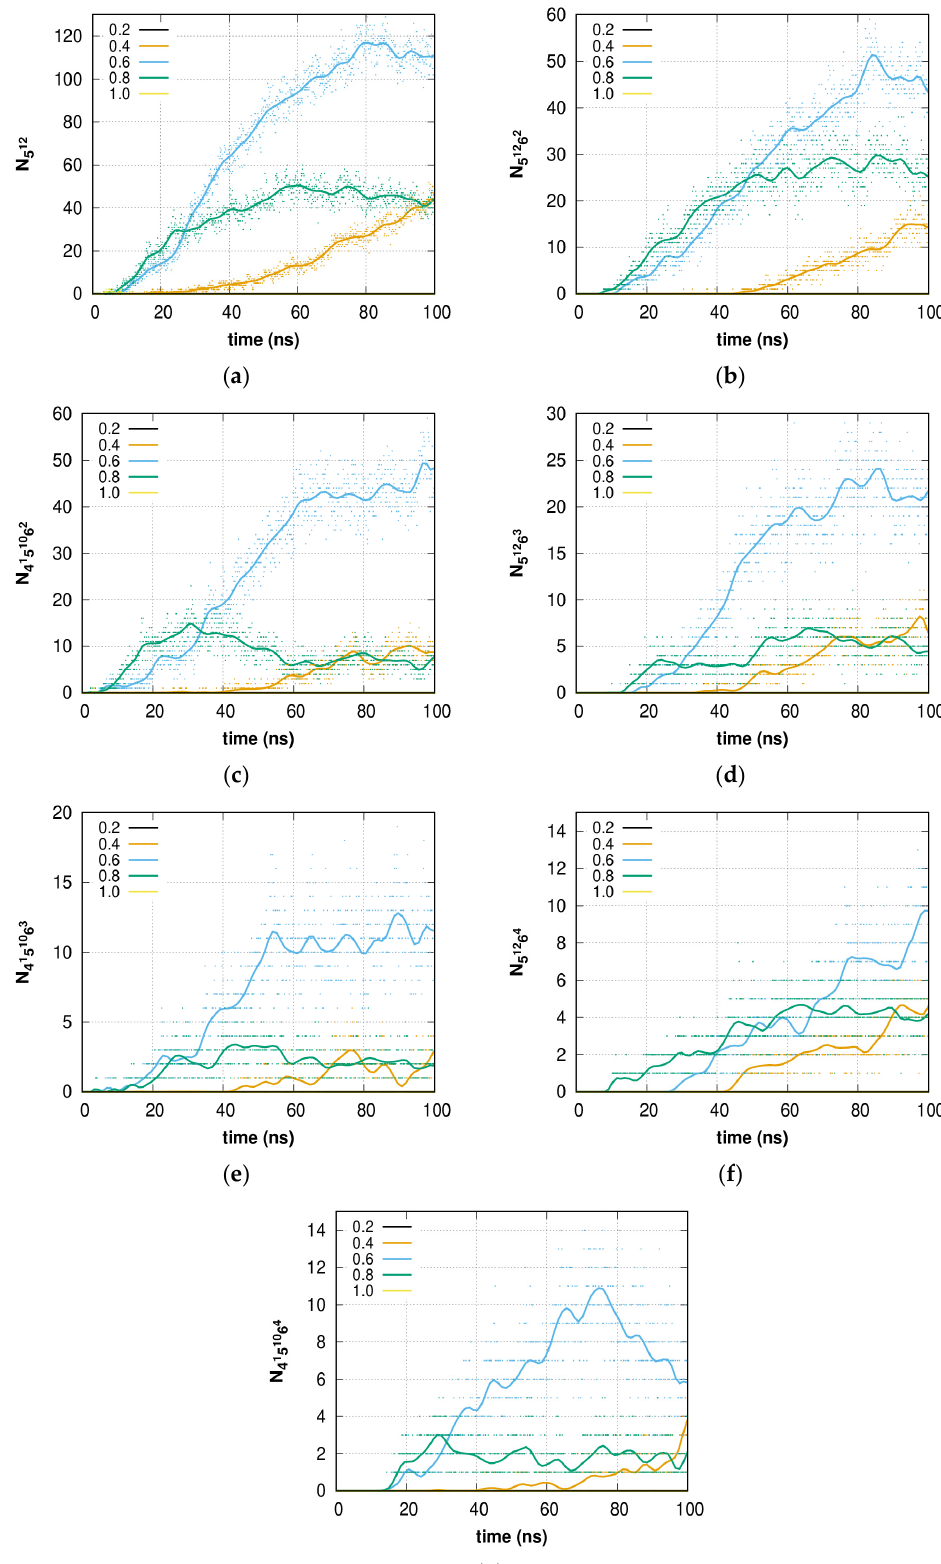
Figure 8. Time dependence of the number of ( a ) 5 12 ; ( b ) 5 12 6 2 ; ( c ) 4 1 5 10 6 2 ; ( d ) 5 12 6 3 ; ( e ) 4 1 5 10 6 3 ; ( f ) 5 12 6 4 ; ( g ) 4 1 5 10 6 4 type cavities of amorphous methane hydrate agglomeration. Solid lines represent the smoothed